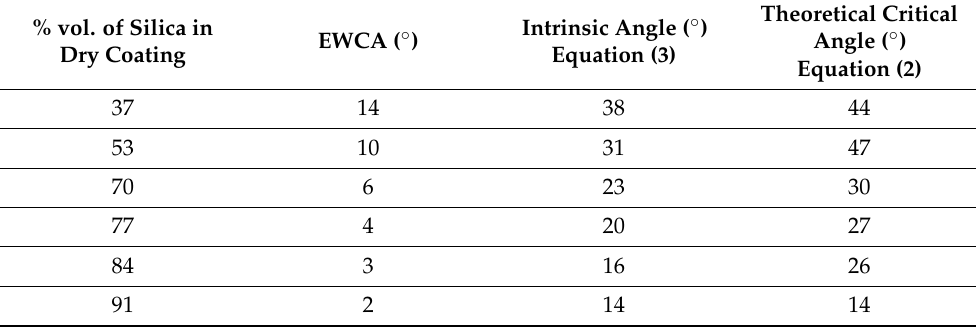
Table 5. EWCA, Intrinsic and Theoretical Critical Angles of Coatings with Different Particle Loadings. % vol. of Silica